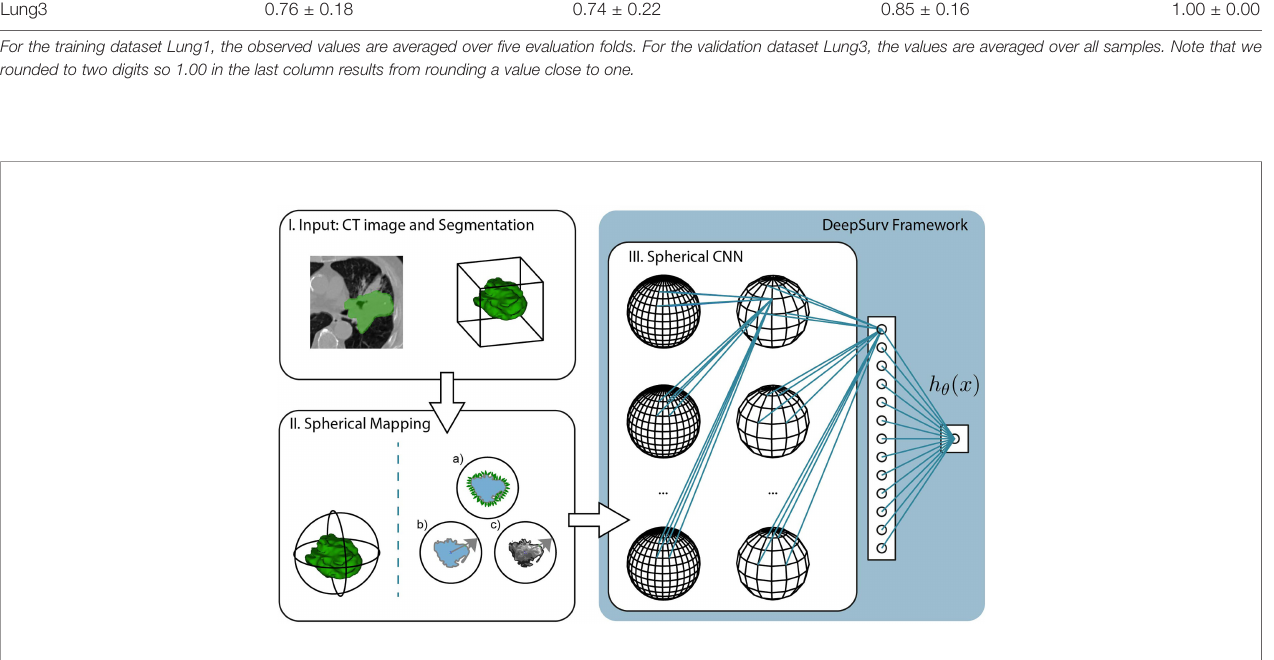
TABLE 1 | Performance metrics (mean ± std) of the automatic segmentation methods evaluated on two lung cancer datasets. Dataset Dice Precision Recall